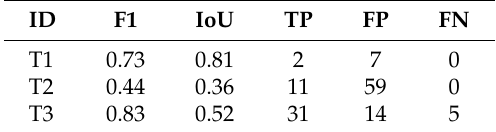
Table 7. Performance obtained on the 3 SAR products in D test used as test